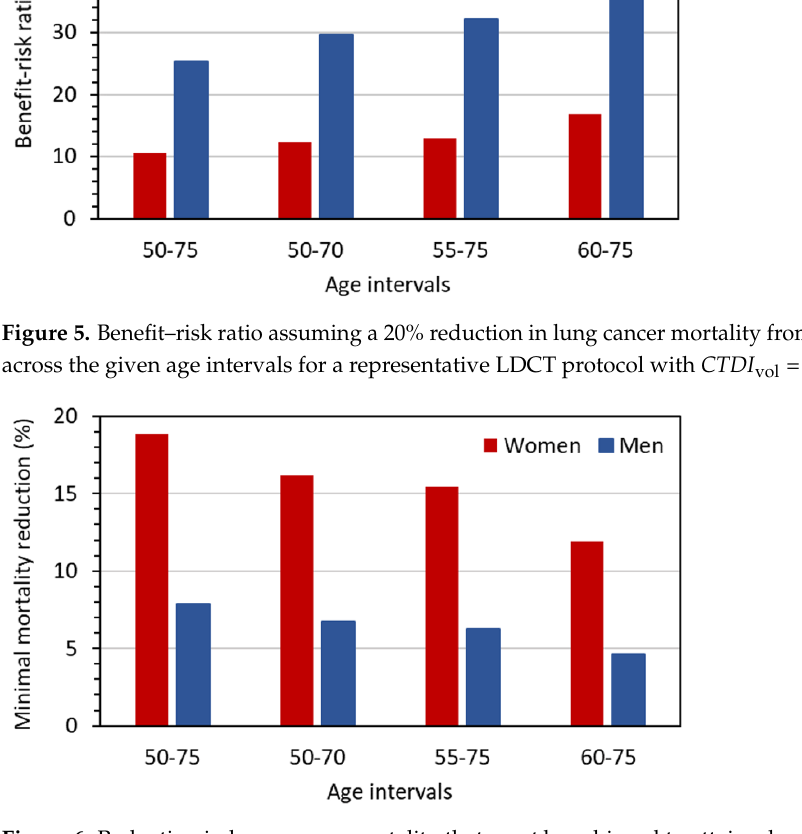
Figure 5. Benefit – risk ratio assuming a 20% reduction in lung cancer mortality from annual screen- ing across the given age intervals for a representative LDCT protocol with CTDI vol = 1 mGy.